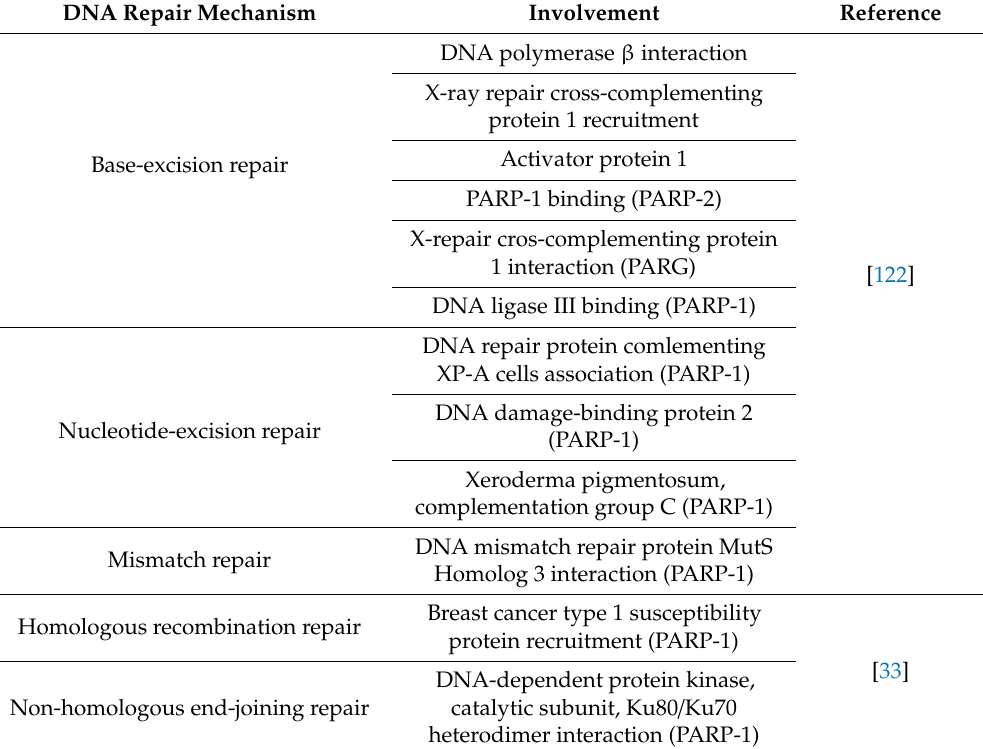
Table 3. The main biological mechanisms involved in DNA repair